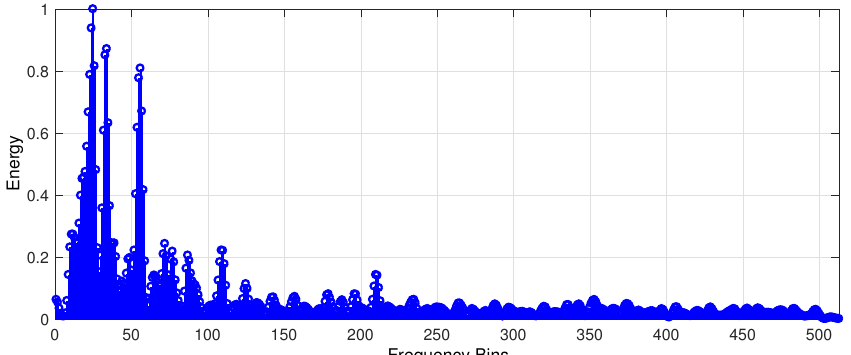
Figure 8. Normalized energy in different frequency bins of observed mixture